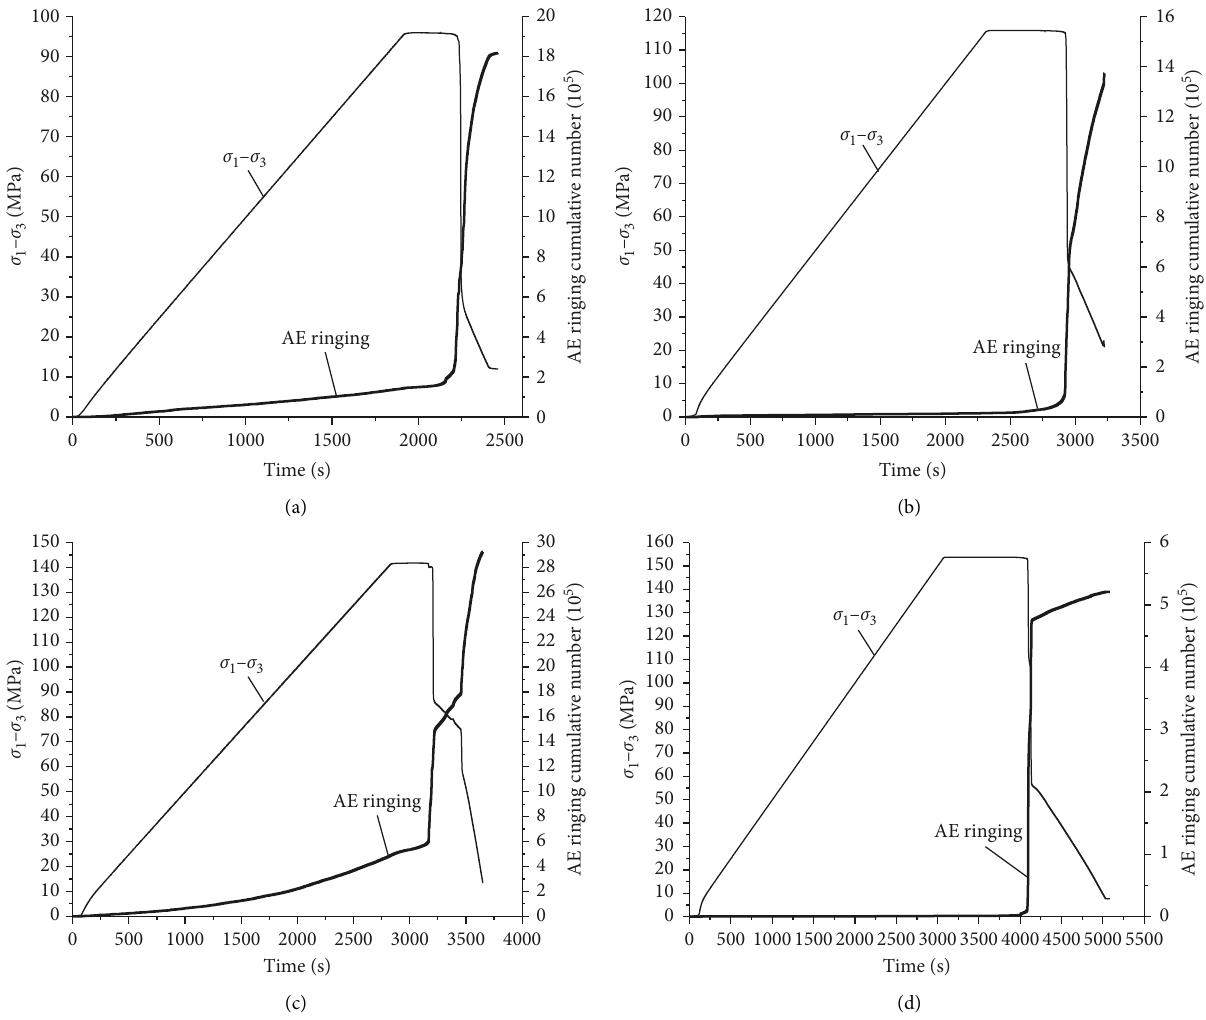
Figure 6: Test results of AE accumulative ringing of rock specimens under unloading confining pressure. (a) The initial value σ initial value σ 3 � 10MPa. (c) The initial value σ 3 � 15MPa. (d) The initial value σ 3 �